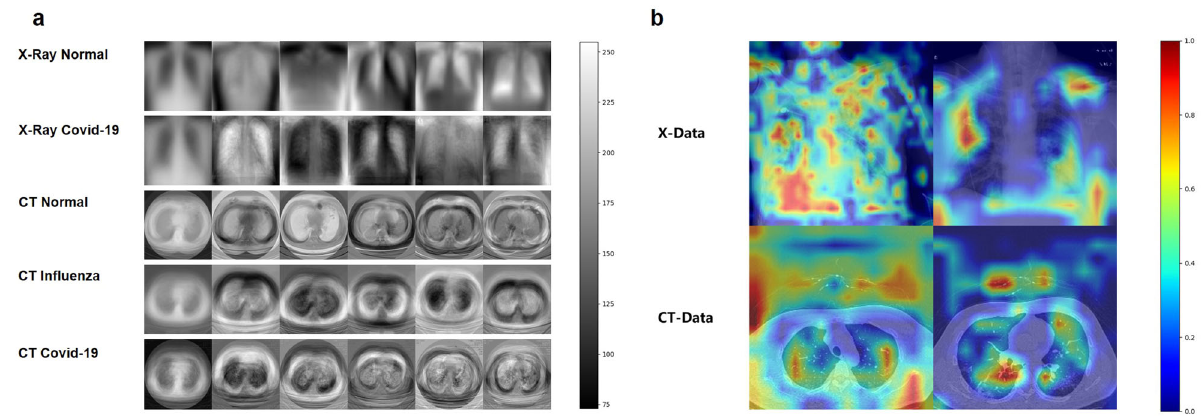
Fig. 2 PCA visualizations and example heatmaps of both X-data and CT-data. a Mean image and eigenvectors of fi ve different sub-data sets. The fi rst column shows the mean image and the other columns show the eigenvectors. The fi rst row shows the mean image and fi ve eigenvectors of the normal CXR images; second row: COVID-19 CXR images, third row: normal CT images, fourth row: in fl uenza CT images, last row: COVID-19 CT images. The scale bar on the right is the range of pixel values of the image data. b Heatmaps of both X-data and CT-data were demonstrated for better interpretability of the proposed frameworks. The scale bar on the right is the probability of the areas being suspected as infections.